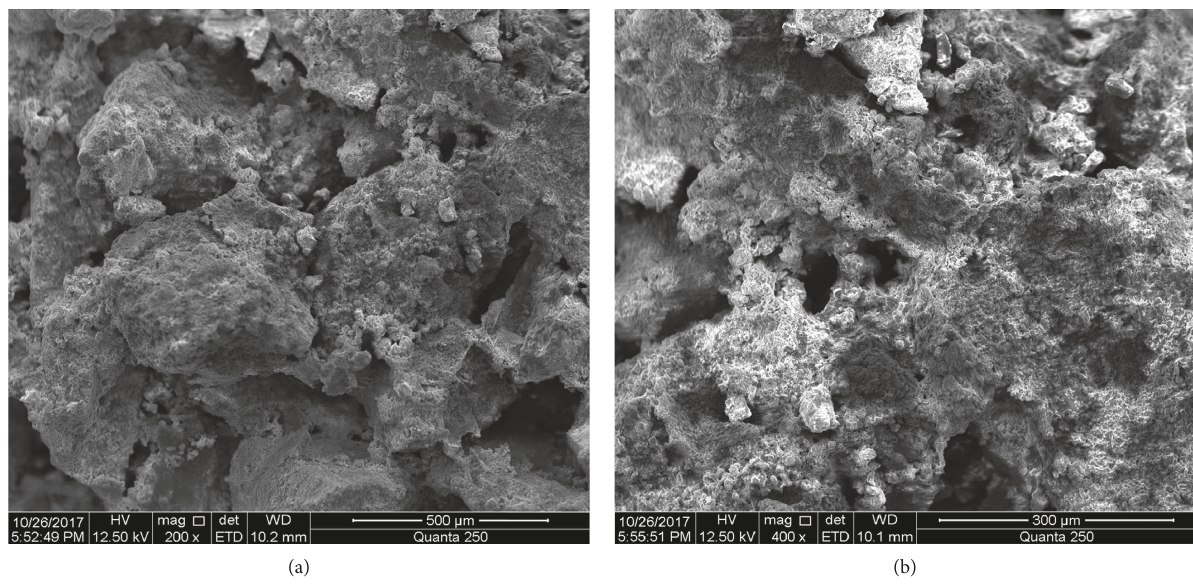
Figure 14: SEM images of uranium tailings reinforced by MICP at the end of experiment (200x :a; 400x :b).